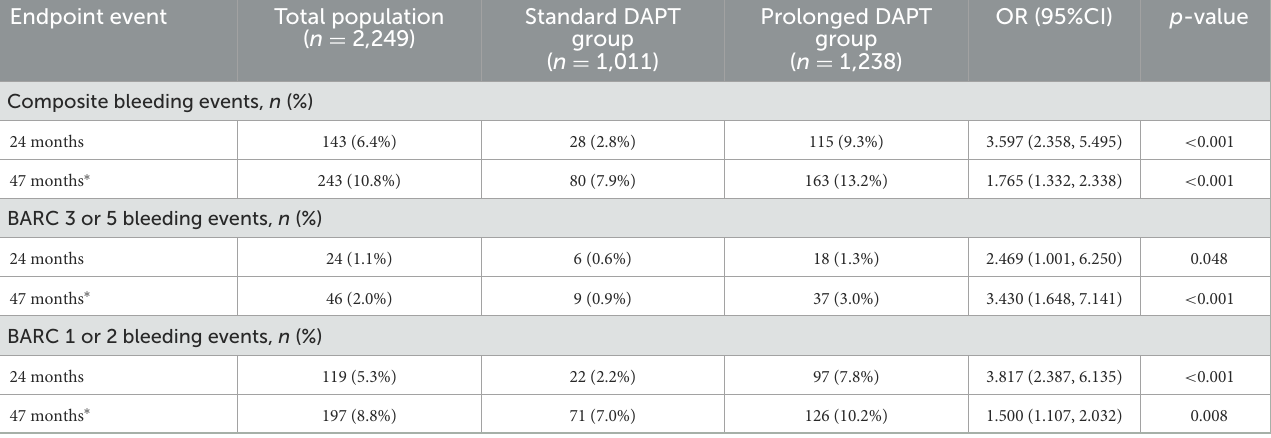
TABLE 4 Incidence of composite bleeding events in the standard and prolonged DAPT groups.